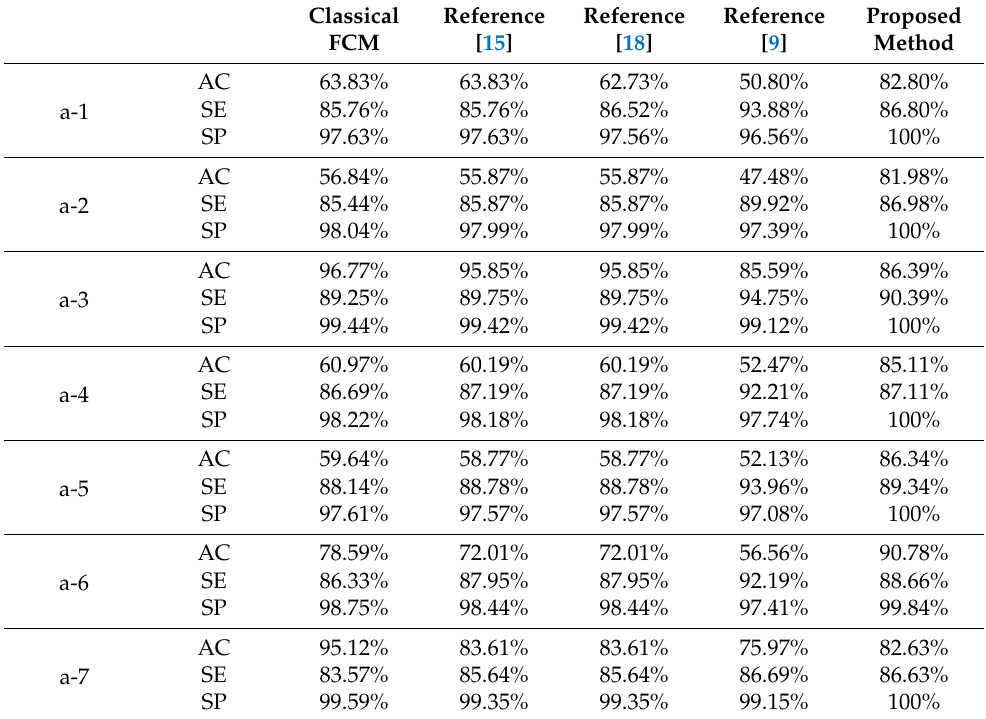
Table 3. Performance comparison of different